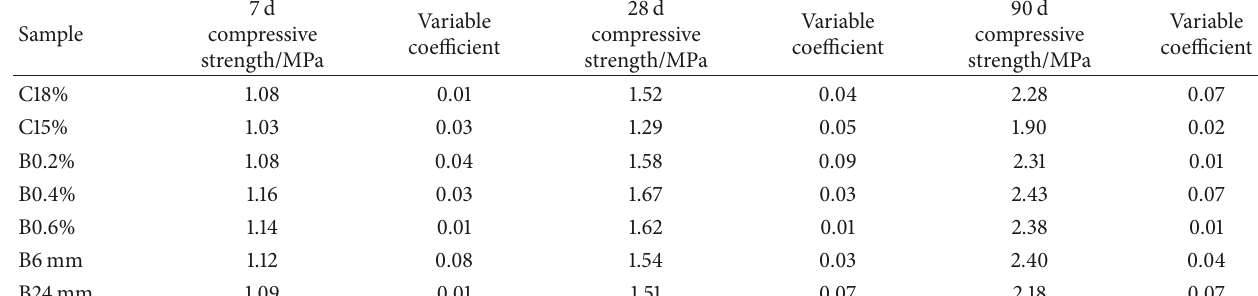
Table 5: The unconfined compressive strength.